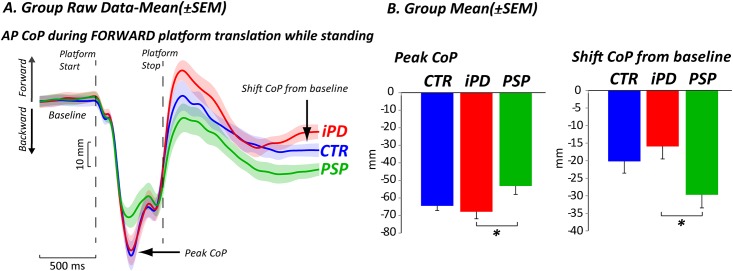
Postural motor control: Forward platform translation.CoP displacement in response to forward platform translations. A) Group raw data mean±SEM B) Group mean±SEM. CoP: center of pressure, CoM: center of mass; AP: anterior-posterior.